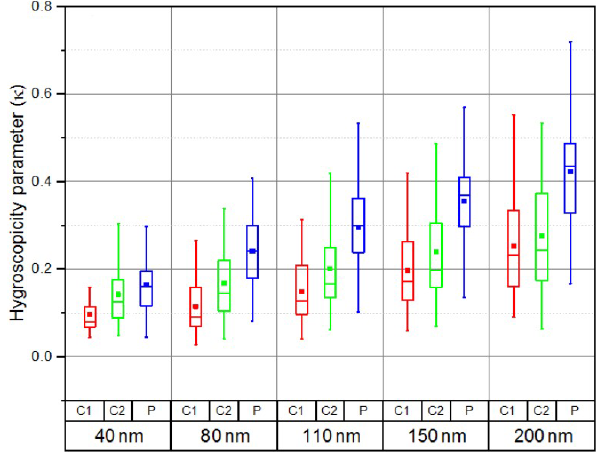
Figure 2. Size-resolved κ during the control clean (C1), the non- control clean (C2), and the non-control polluted (P) periods. Solid squares represent the average κ , boxes represent the 25th, 50th, and 75th percentiles, and extremities represent the 5th and 95th per- centiles. Reprint with permission by Y. Wang et al.